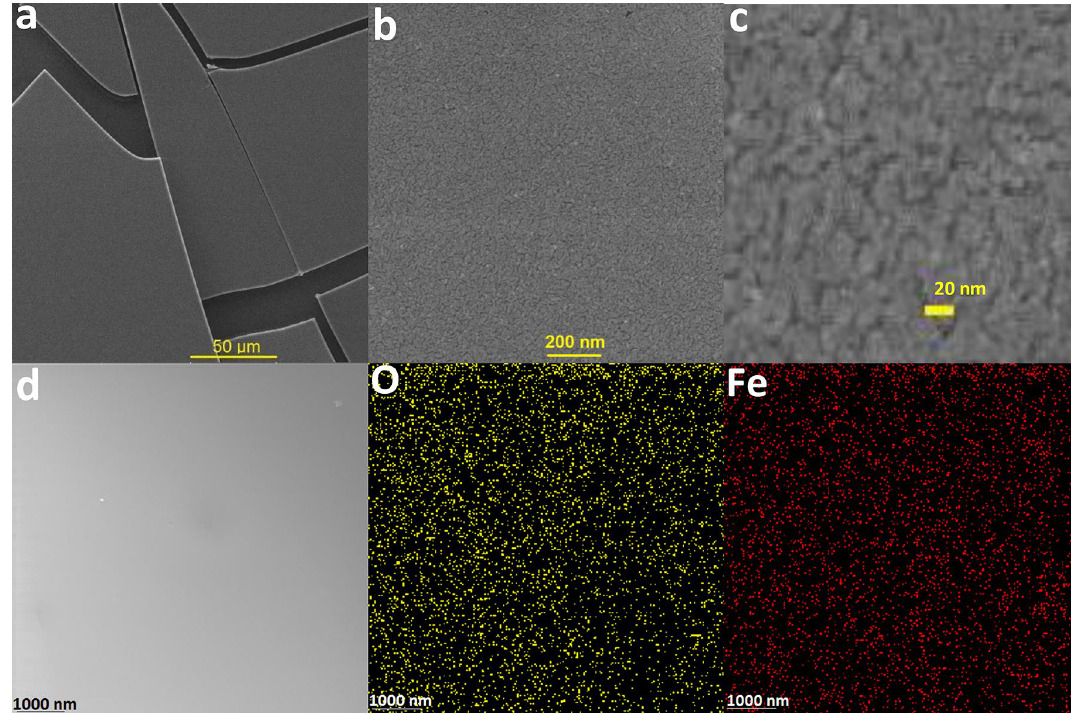
Figure 2. SEM images of 1 at different magnifications ( a – c ). EDX-Mapping for oxygen (yellow) and iron (red) on the surface of 1 ( d ).